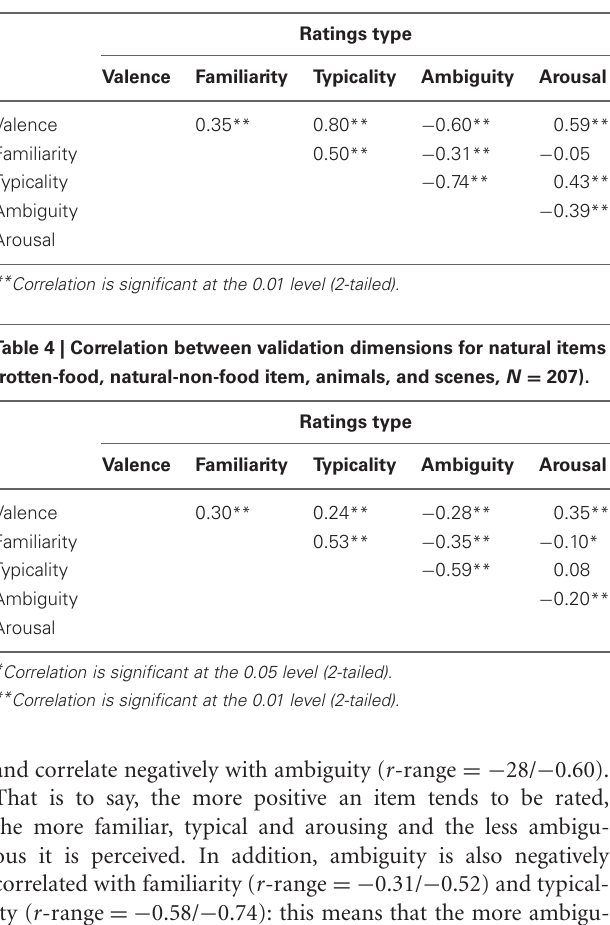
Table 3 | Correlation between the validation dimensions for objects (artificial food-related objects and artificial objects, N = 418).